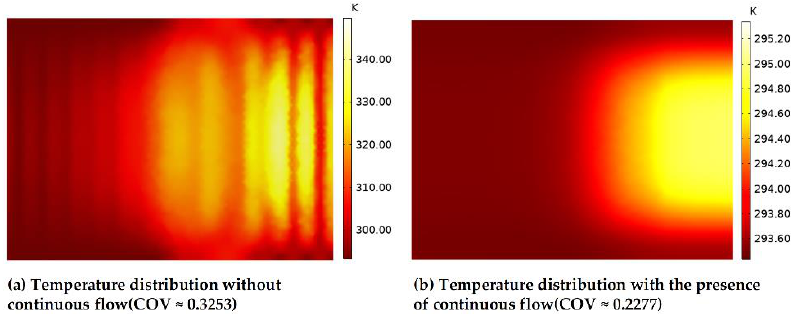
Figure 5. Temperature distributions with and without continuous flow.